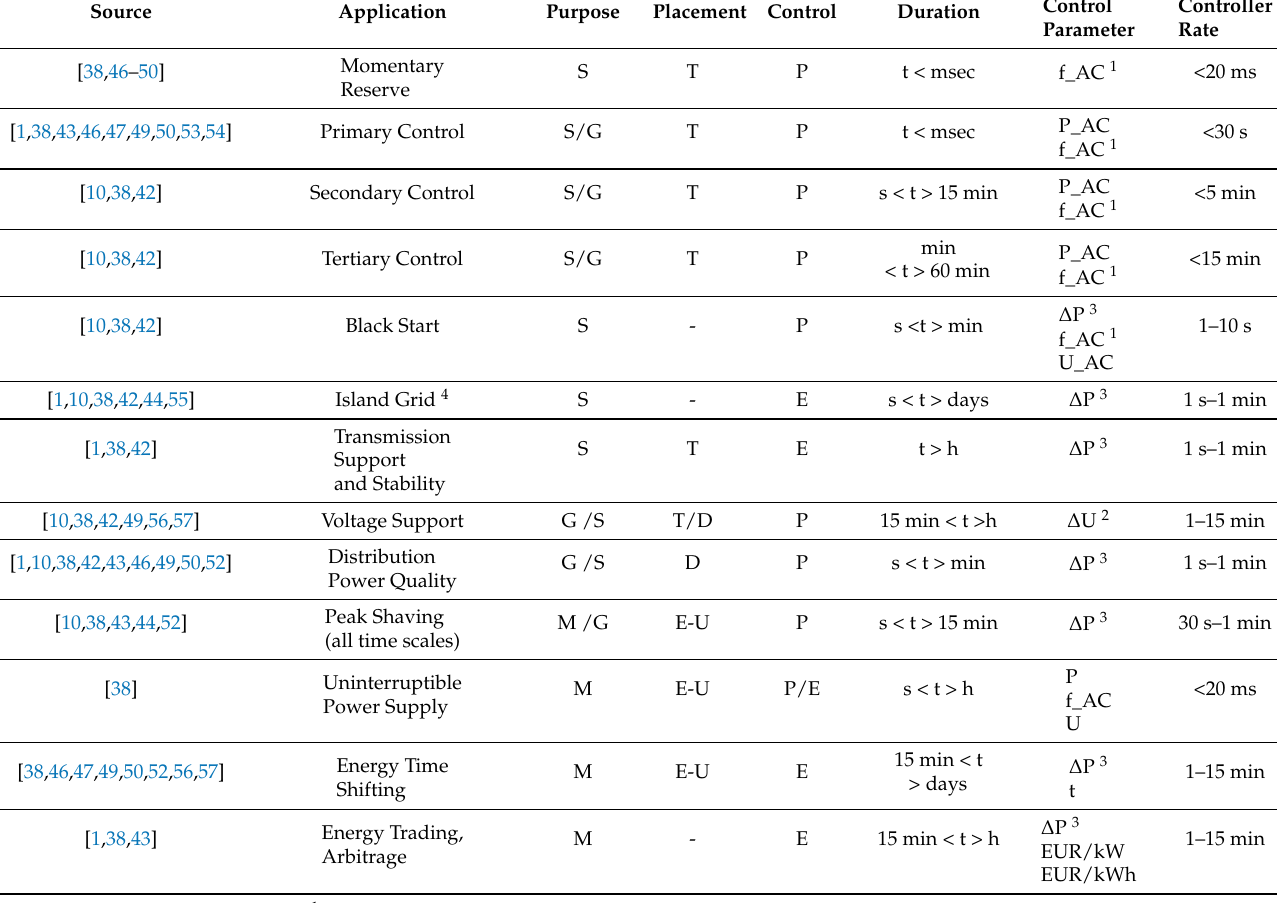
Table 4. Classification of storage application scenarios by their application purpose (S: System; G: Grid; M: Manage), placement (T: Transmission; D: Distribution), control level (P: Power; E: Energy), duration, control parameters, and controller rate. Literature review from